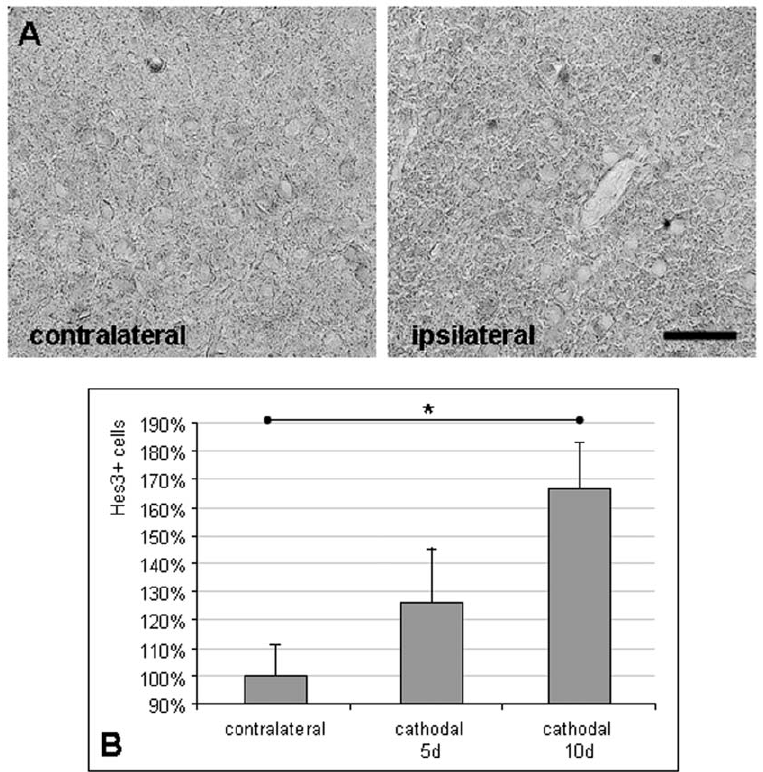
Figure 5. Cathodal tDCS increases the number of Hes3-positive neural stem cells in the cortex. (A) The density of NSC identified by Hes3 immunoreactivity was increased in the cortex ipsilateral to multi-session tDCS (scale bar =0.05 mm). (B) The number of Hes3-positive NSC increased in the ipsilateral hemisphere with the duration of cathodal tDCS (means 6 SEM; *p , 0.05).